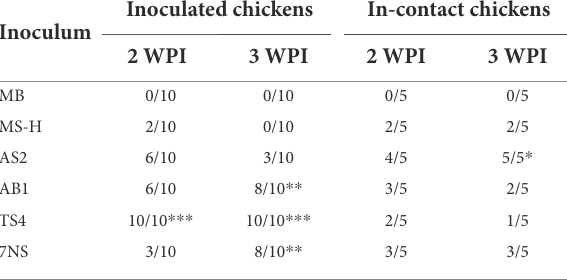
TABLE 3 Seropositivity of the M. synoviae cultures 2- and 3-week after aerosol inoculation of SPF chickens with various strains or reisolates of M. synoviae following intratracheal inoculation with a virulent strain of IBV, and 2- and 3-week after exposure of in-contact chickens with the inoculated chickens.